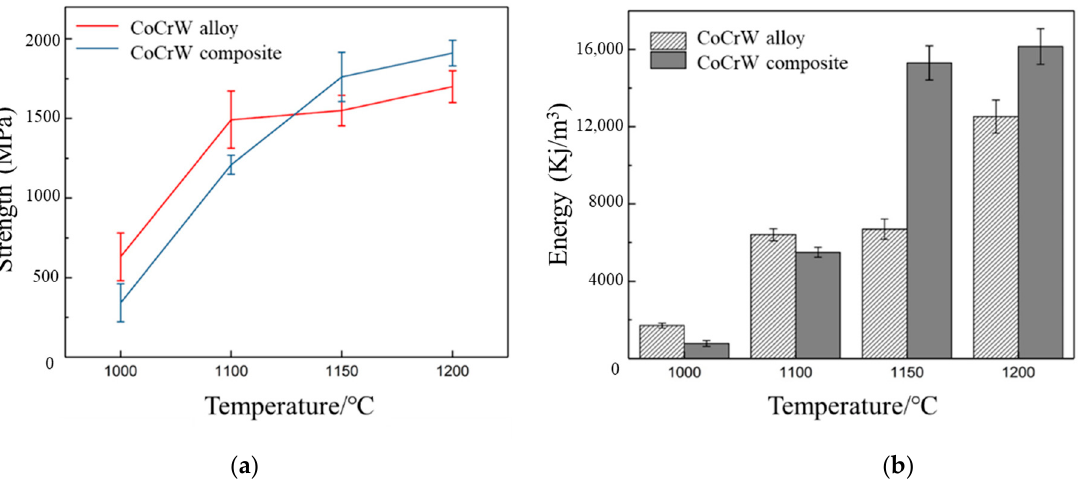
Figure 11. Results of the three ‐ point bending experiment. ( a ) The bending strength of the Co–Cr–W alloy and the compo ‐ sites; ( b ) the toughness statistical diagram of the Co–Cr–W alloy and the composites.